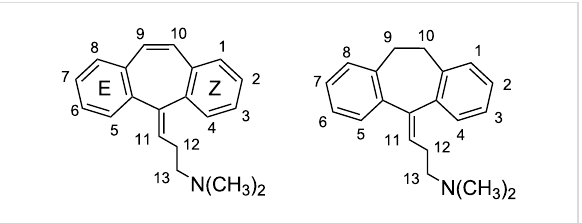
Figure 1: Molecular formulae and atom numbering of cyclobenzaprine ( 1 , left) and amitriptyline ( 2 , right). E and Z symbols are arbitrarily intro- duced to identify the two aromatic